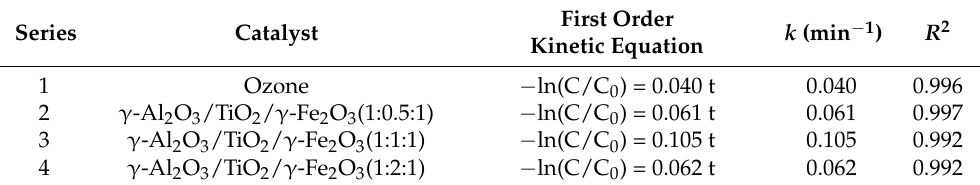
Figure 6. Kinetic study of ibuprofen degradation by magnetic γ -Al 2 O 3 base ozone catalyst. Table 2. First-order dynamics parameters (magnetic γ -Al 2 O 3 -based ozone catalyst).